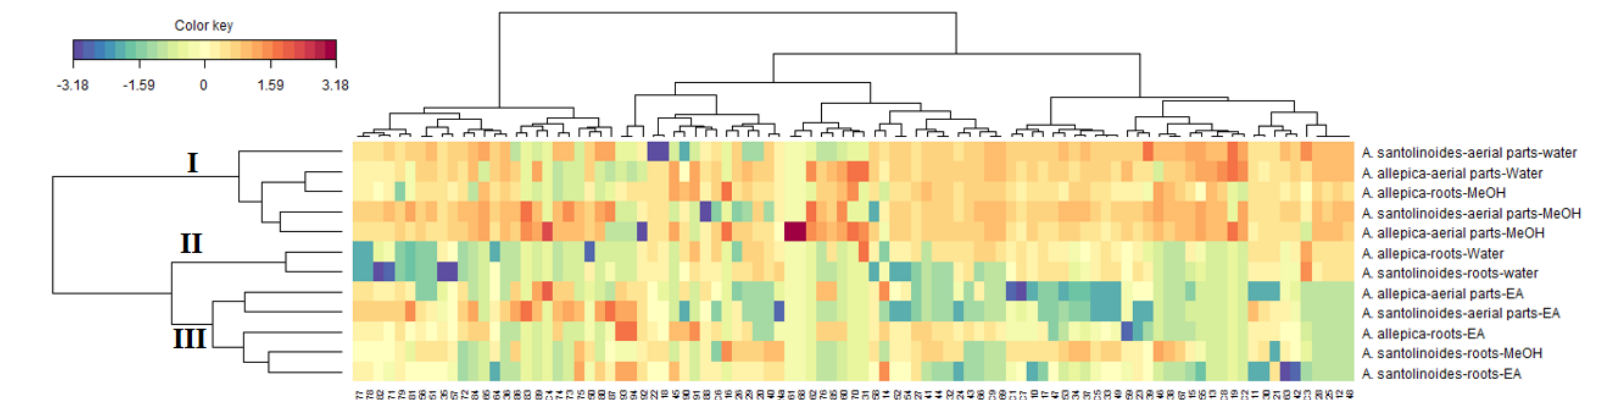
Figure 2. Clustered Image Map on the relative quantitative metabolites data obtained through UHPLC-MS analysis (Red color: High concentration, Blue color: low concentration). (C1) protocatechuic acid-O-hexoside, (C2) caffeoylgluconic acid, (C3) protocatechuic acid, (C4) p-hydroxyphenylacetic acid-O-hexoside, (C5) protocatechuic acid-O-hexoside isomer, (C6) syringic acid 4-O-hexoside (C7) neochlorogenic (3-caffeoylquinic) acid, (C8) caffeoylgluconic acid isomer, (C9) caffeic acid-O-hexoside, (C10) gentisic acid-O-hexoside, (C11) vanillic acid 4-O-hexoside, (C12) caffeoylgluconic acid isomer, (C13) O-caffeoyl hexose isomer, (C14) 4-hydroxybenzoic acid, (C15) 4-hydroxybenzoic acid-hexoside, (C16) p-hydroxyphenylacetic acid O-hexoside, (C17) quinic acid, (C18) chlorogenic (5-caffeoylquinic) acid, (C19) p-coumaric acid, (C20) 3-feruloylquinic acid, (C21) p-hydroxyphenylacetic acid, (C22) caffeic acid, (C23) gentisic acid, (C24) 5-p-coumaroylquinic acid, (C24a) 1,3-dicaffeoylquinic acid, (C25) caffeic acid-O-hexoside isomer, (C26) 5-feruloylquinic acid, (C27) m-coumaric acid, (C28) 5-p-coumaroylquinic acid isomer, (C29) 4-feruloylquinic acid, (C30) vanillic acid, (C31) o-coumaric acid, (C32) vanillic acid-4-O-(6-O-caffeoyl)-hexoside, (C33) 3,4-dicaffeoylquinic acid, (C34) 1,5-dicaffeoylquinic acid, (C35) 3,5-dicaffeoylquinic acid, (C36) dicaffeoyl-tetrahydroxy-pentanoic acid, (C37) 4,5-dicaffeoylquinic acid, (C38) shikimic acid, (C39) salicylic